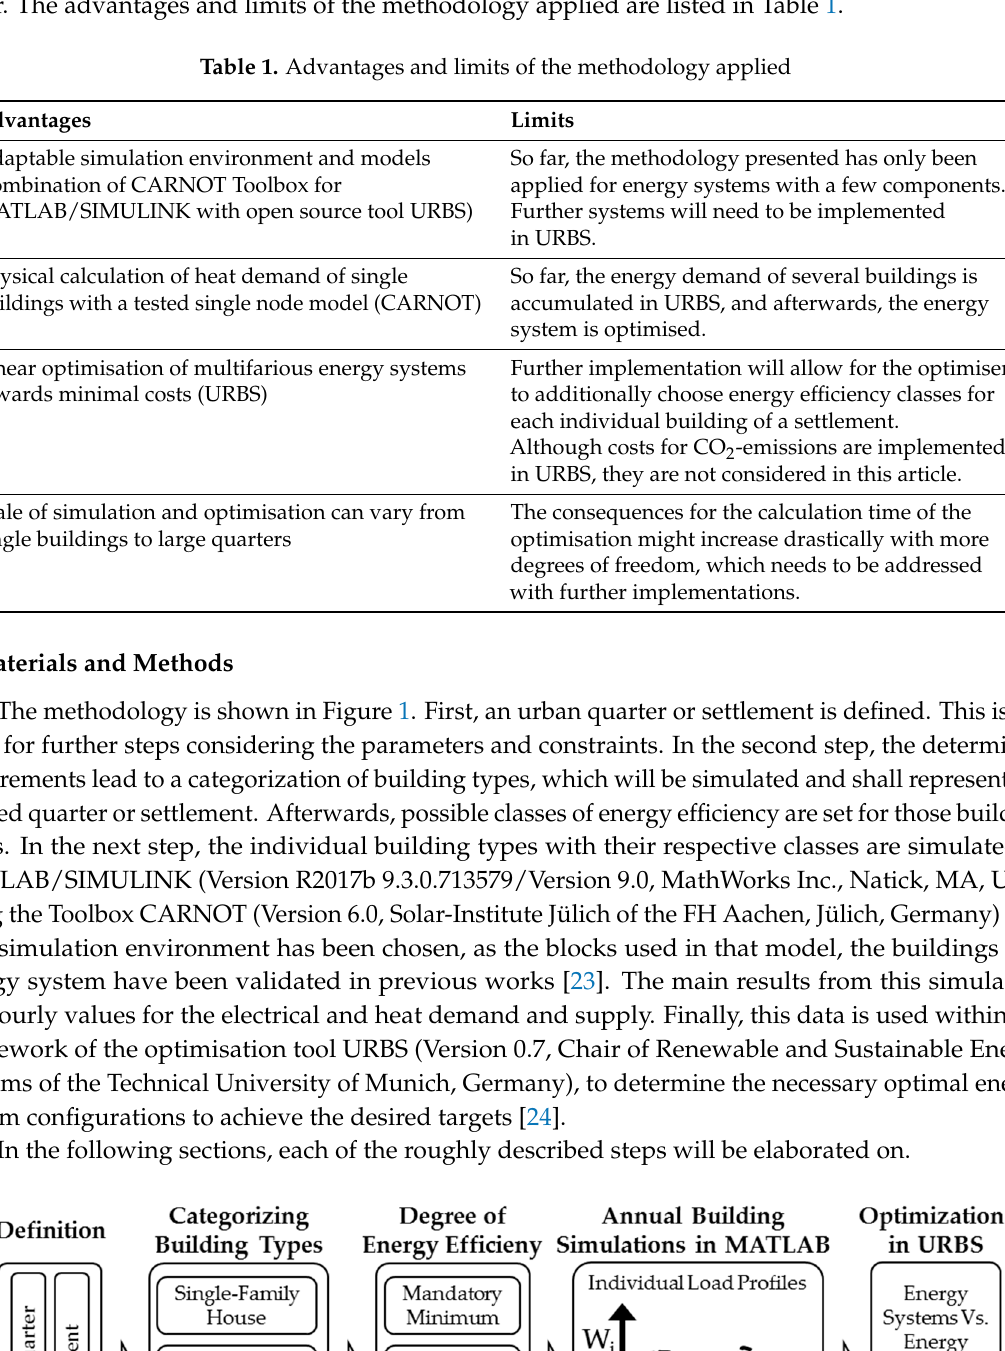
Table 1. Advantages and limits of the methodology applied